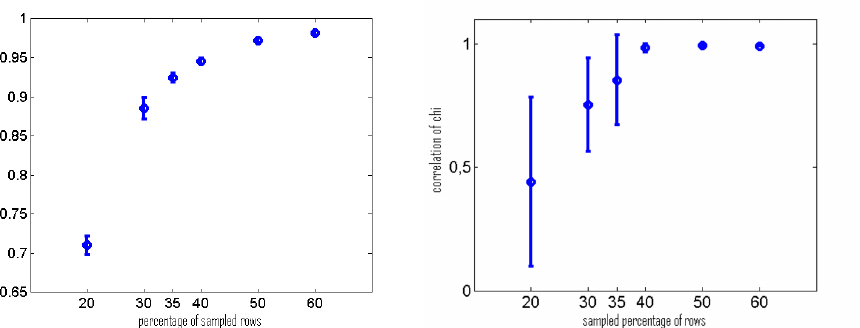
Figure 6: Left: Mean correlation between the stationary distribution based on a fully provided matrix P and based on a subsam- pling of a certain percentage of rows of P. Right: Mean correlation coefficient between the χ matrices, fully provided vs. subsam- pled matrix P. Each shown mean value and the standard deviations are based on 5 different statistical experiments.